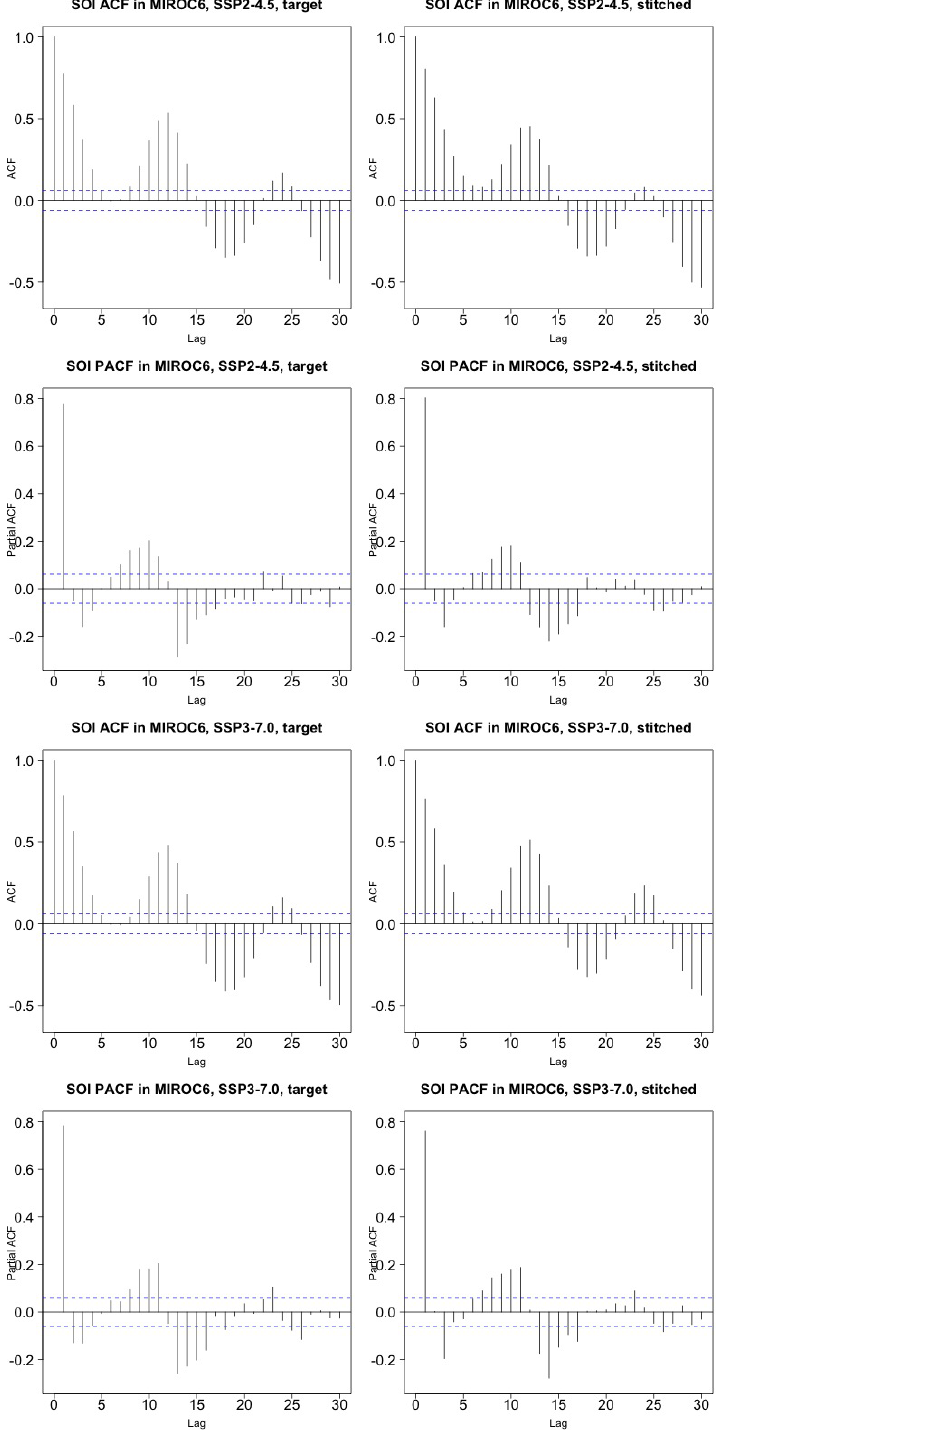
Figure D4. Auto-correlation functions (ACFs) and partial auto-correlation functions (PACFs) for real and stitched SOI time series. Top two rows: SSP2-4.5 ACF for target and stitched series and respective PACFs. Bottom two rows: SSP3-7.0 ACF for target and stitched series and respective PACFs. Results from emulation of one of three ensemble members emulated under each scenario for MIROC6. (Our software – R function acf(..,type="partial") – does not define the PACF at lag zero.)